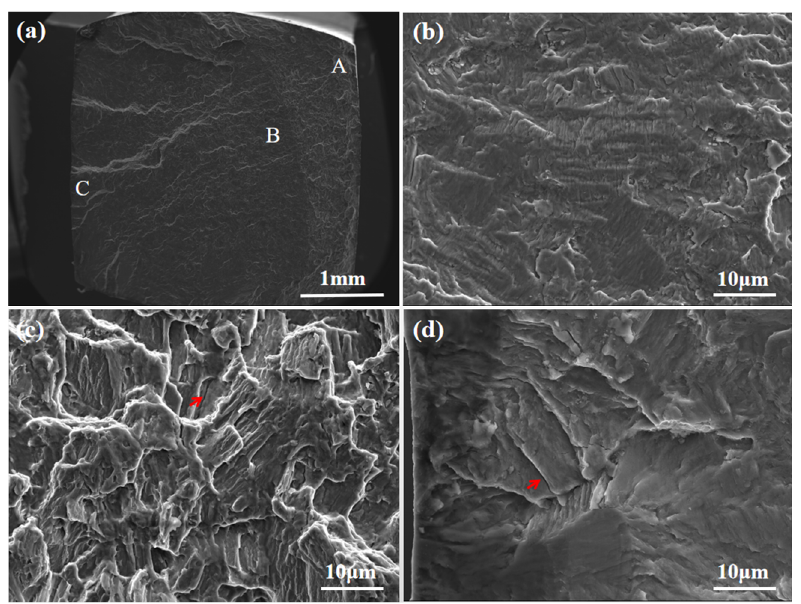
Figure 6. Fatigue fracture morphology of strain amplitude at 0.5% along ND: ( a ) typical fatigued fracture regions labeled as A (crack initiation), B (propagation), and C (final fracture); ( b , c ) crack initiation fracture zone; ( d ) final fracture zone.